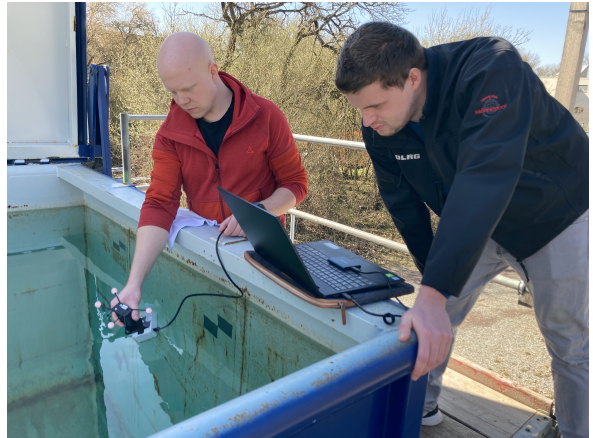
Figure 3. Intel T256 moved in the water above the calibration pattern during the calibration process.